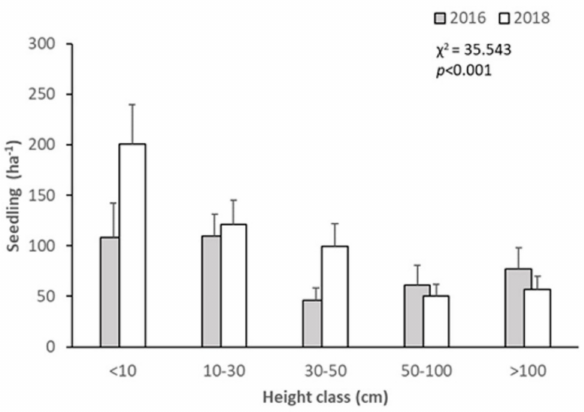
Figure 5. Short-term dynamics of Abies nephrolepis seedlings along height class for two years (2016 and 2018).